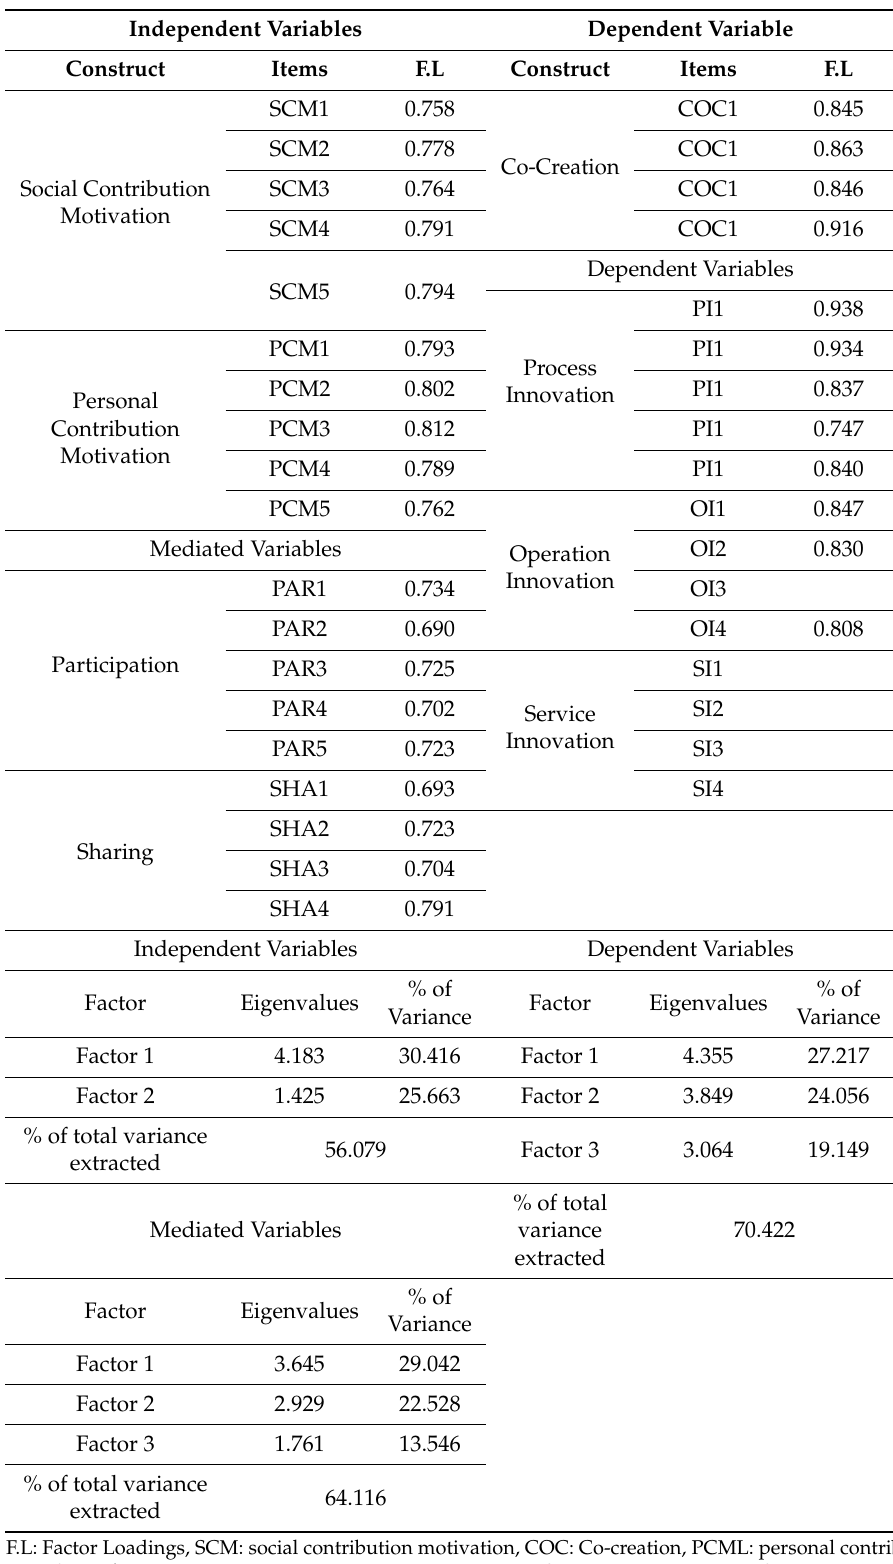
Table 3. Results of factor